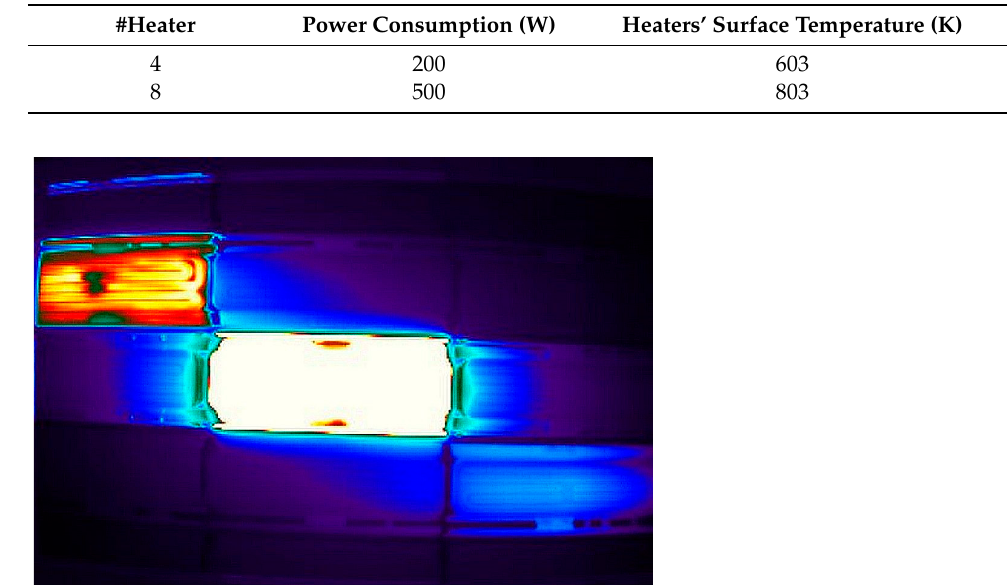
Table 2. Initial condition of heating elements for test.